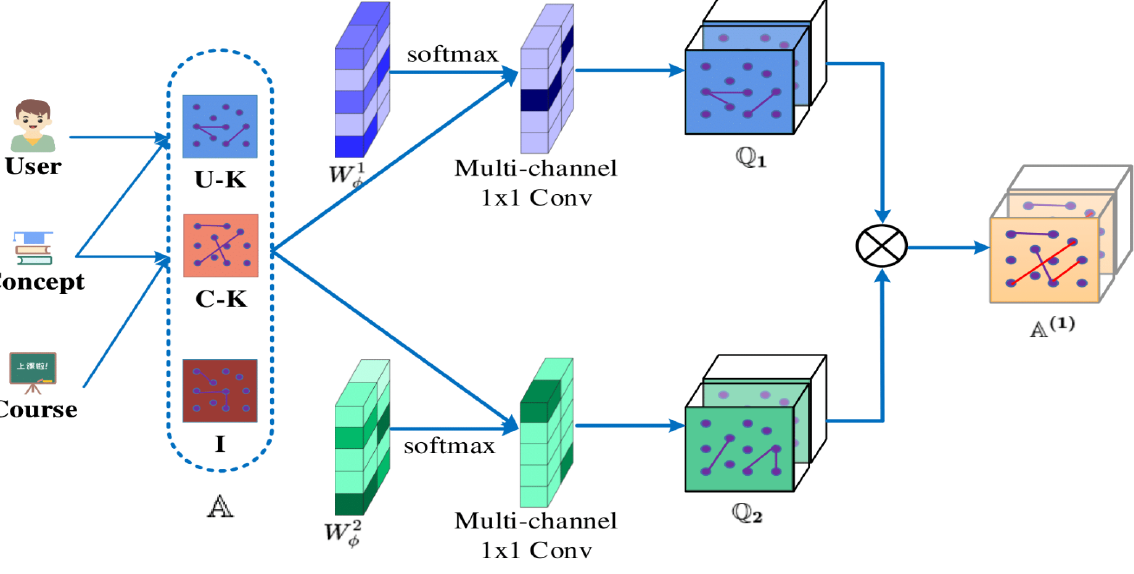
Figure 4. Meta-path generation (MG)